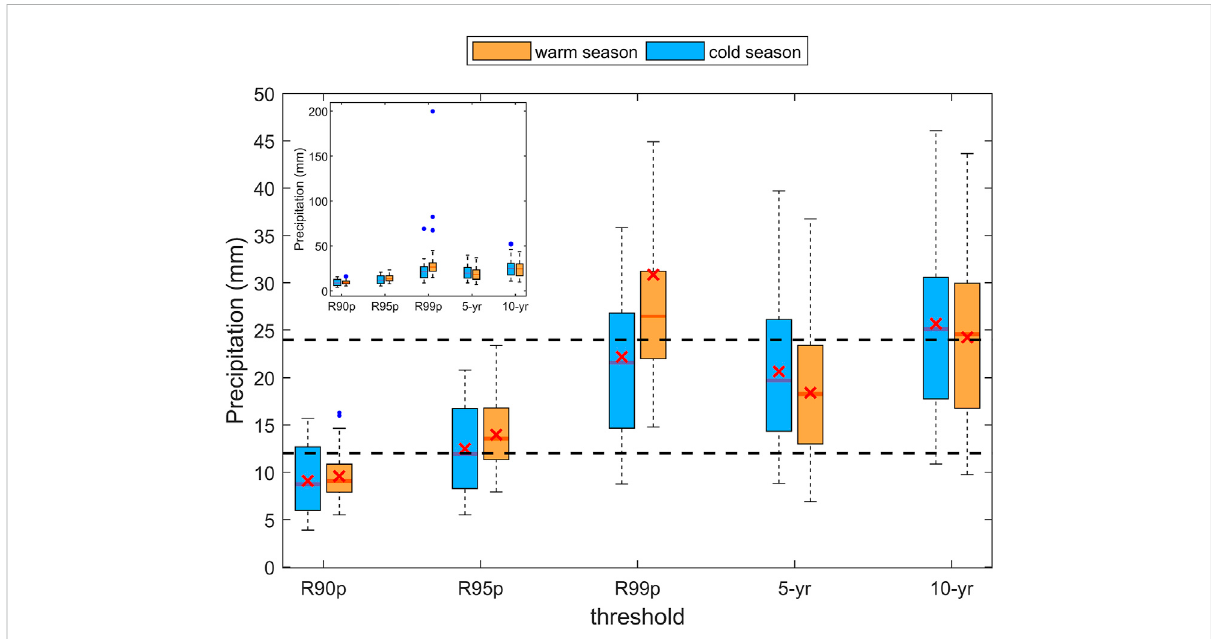
FIGURE 3 Statistics of the different threshold distribution for each station (Red line: median of the thresholds at multiple stations, X: the mean, Point: the outlier, black line: the fi xed-value of 12mm, 24 mm